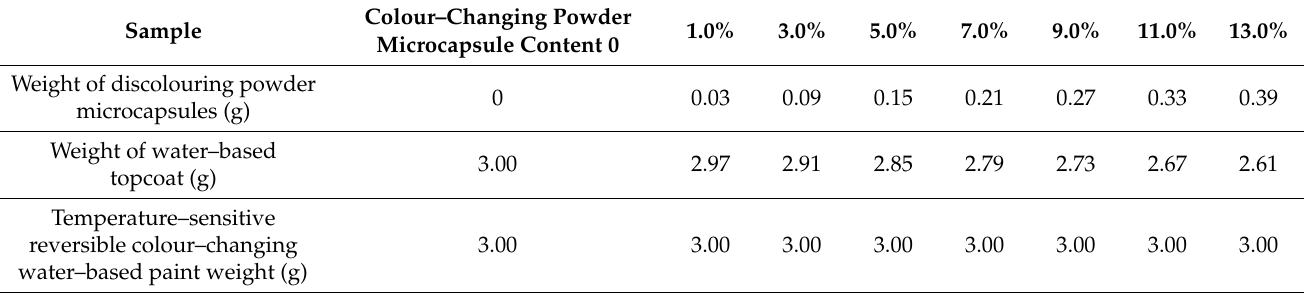
Table 2. Table of ingredients for paint films with microcapsules of colour–changing